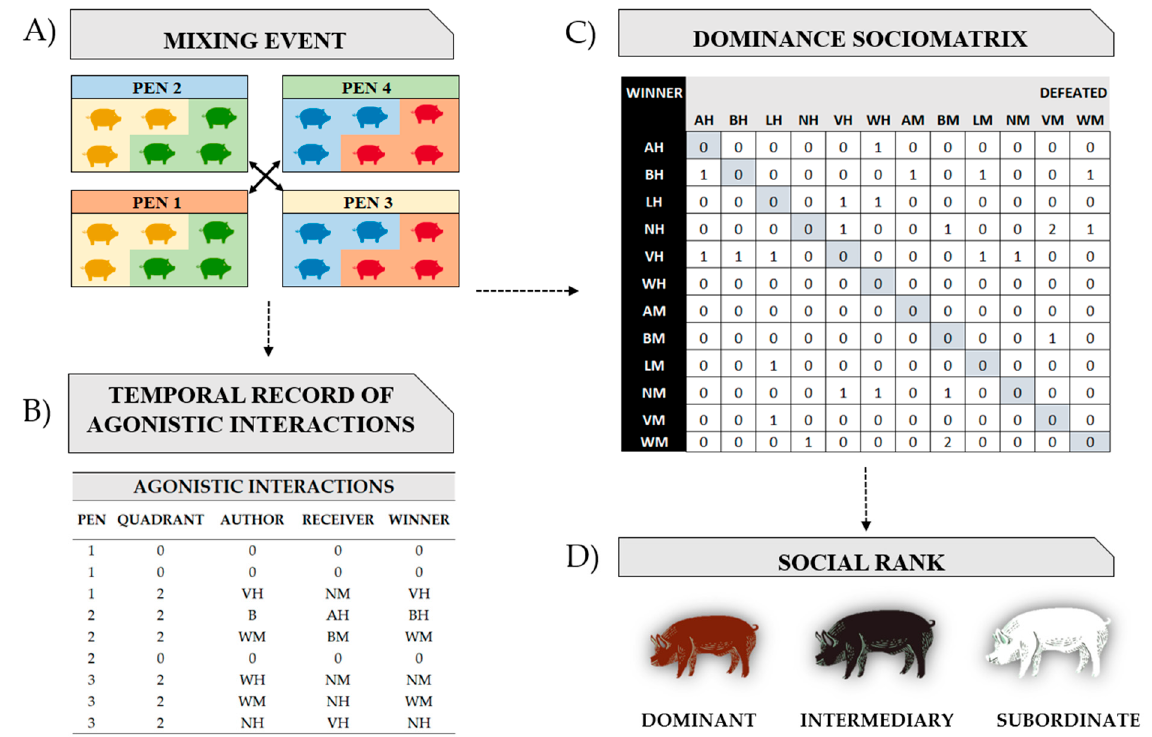
Figure 4. Diagram highlighting the different steps required to establish dominance hierarchies. The outcome of dyadic agonistic interactions between individuals was recorded in the temporal sequence of winners and losers in a matrix. ( A ) mixing event; ( B ) Continuous event sampling recording all occurrences of agonistic interactions [72 h after mixing]; ( C ) Accumulated frequencies of wins and losses per pen for each individual; ( D ) Social rank establishment: dominant (higher number of victories and lower number of defeats), subordinate (higher number of defeats and lower number of victories), and intermediary (low number of interactions within the pen).